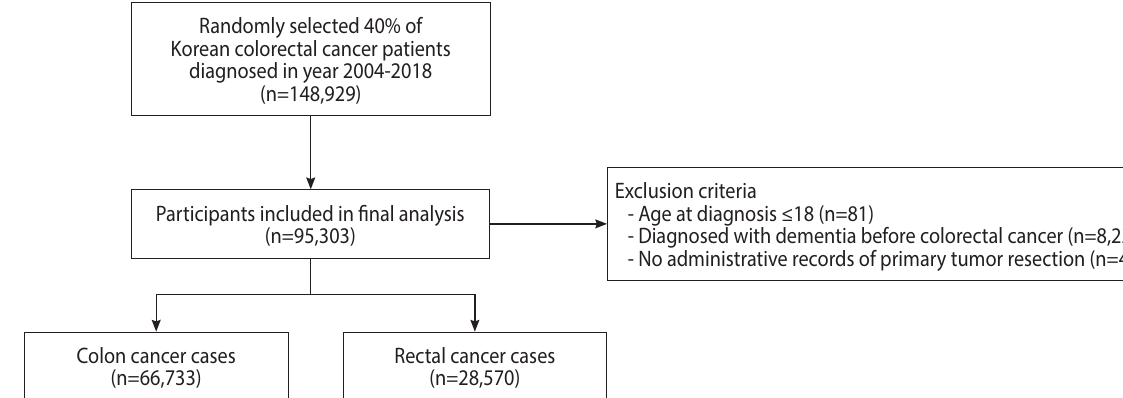
Figure 1. Flow chart of participant inclusion and